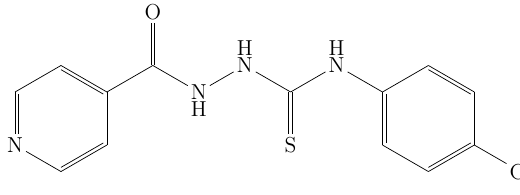
Figure 4. Molecular structure of the INH analog.